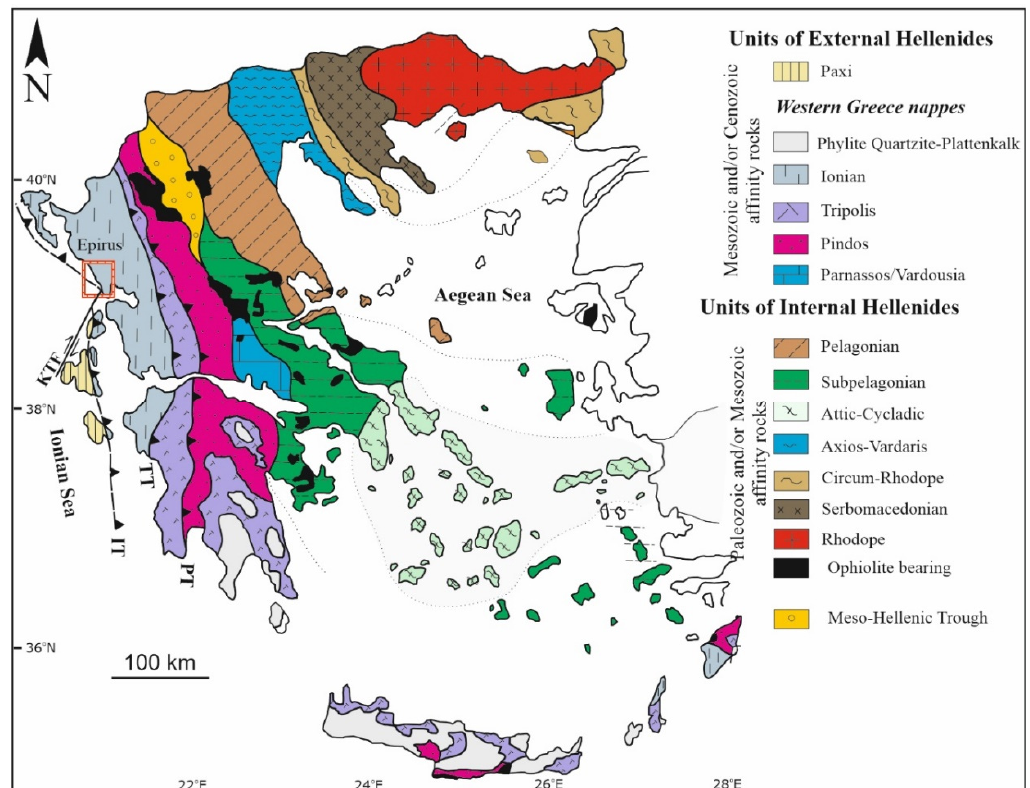
Figure 1. Simplified geotectonic map of Greece modified after [41]. Key: rectangle indicates the study area shown in Figure 2; KTF = Kephalonia Transform Fault, IT = Ionian Thrust, PT = Pindos Thrust, TT = Tripolis Thrust.